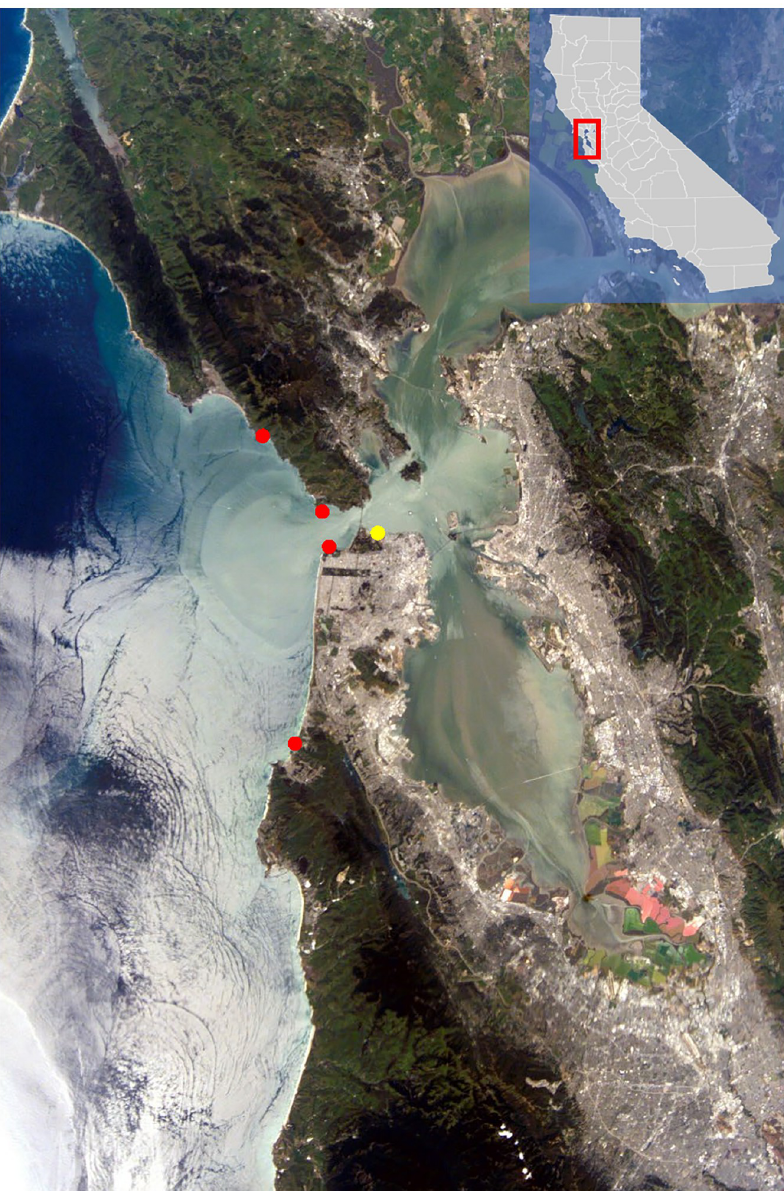
Fig 1. Field sites North to South: Slide Ranch, Point Bonita, Mile Rock Beach, and Rockaway Beach. Sites superimposed as red dots on a satellite image of the freshwater plume, seen as lighter color, exiting the SF Bay on 04/ 21/2002. The Fort Point buoy is represented with a yellow dot. White clouds cover the ocean at Rockaway Beach and further south. Image: NASA, accessed at https://eol.jsc.nasa.gov/searchphotos/photo.pl?mission=ISS004&roll=